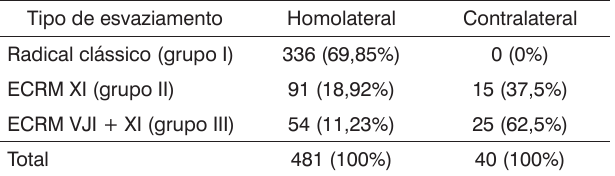
Tabela 2. Distribuição dos esvaziamentos em função das estruturas preservadas e lateralidade em relação ao tumor primário.